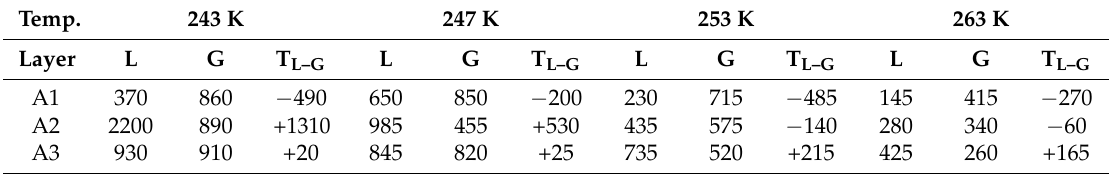
Table 1. Required dissociation time (in picosecond) for each layer in different simulation temperature.